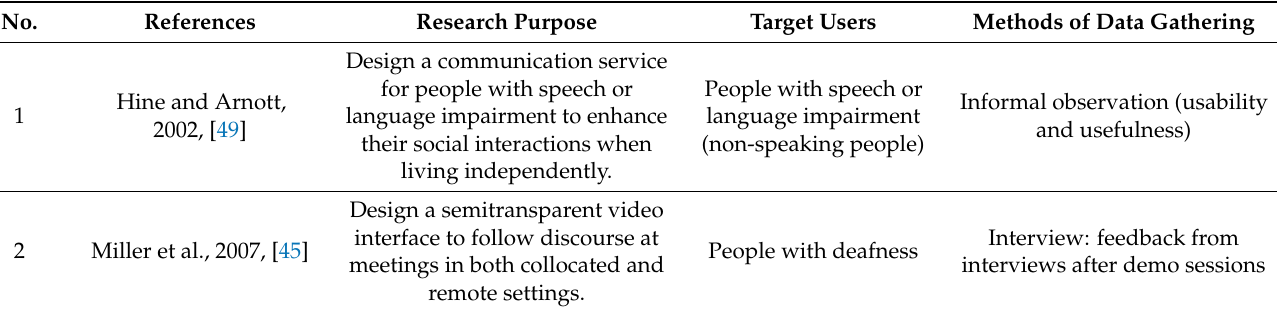
Table A1. Summary of studies and